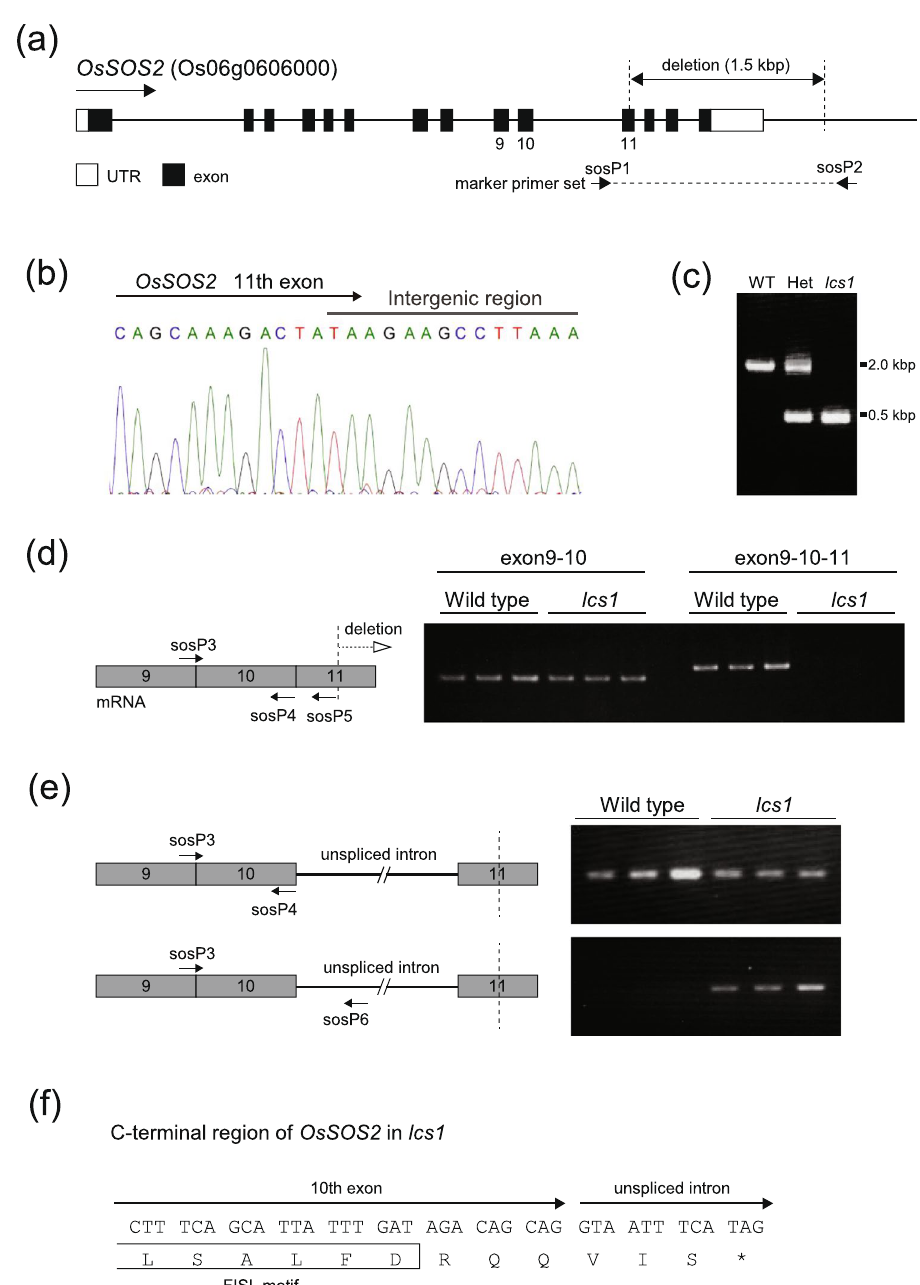
Figure 2. Identification of the gene responsible for the decreased Cs + uptake in lcs1 . ( a ) Structure of OsSOS2 ( Os06g0606000 ) and the mutation site in lcs1 . ( b ) Genomic sequence of the mutation site: exon 11 of OsSOS2 is joined to the intergenic region. ( c ) Fragments of the genomic region containing the mutation site amplified using the marker primer set sosP1and sosP2 shown in ( a ). Het, an F 1 plant derived from a cross between WT and lcs1 . ( d ) RT-PCR analyses of OsSOS2 transcripts using the primers sosP3, sosP4, and sosP5 designed to recognize exons 9–11. RNA was extracted from the whole roots of 8-day-old seedlings. ( e ) RT-PCR analysis of transcripts using the primers sosP3, sosP4, and sosP6. ( f ) Codons and the amino acid sequence around the junction between exon 10 and the unspliced intron of OsSOS2 in lcs1 . The FISL motif is a site for SOS3